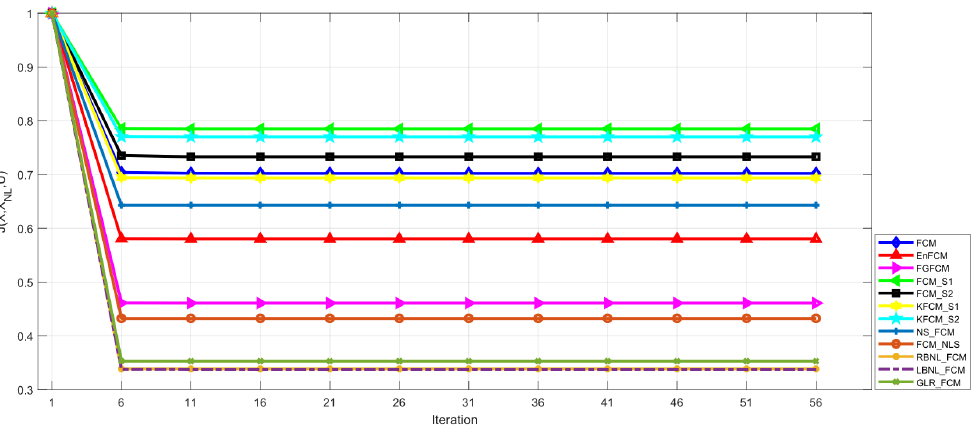
Figure 8. The objective function change curve of each algorithm on the first simulated SAR